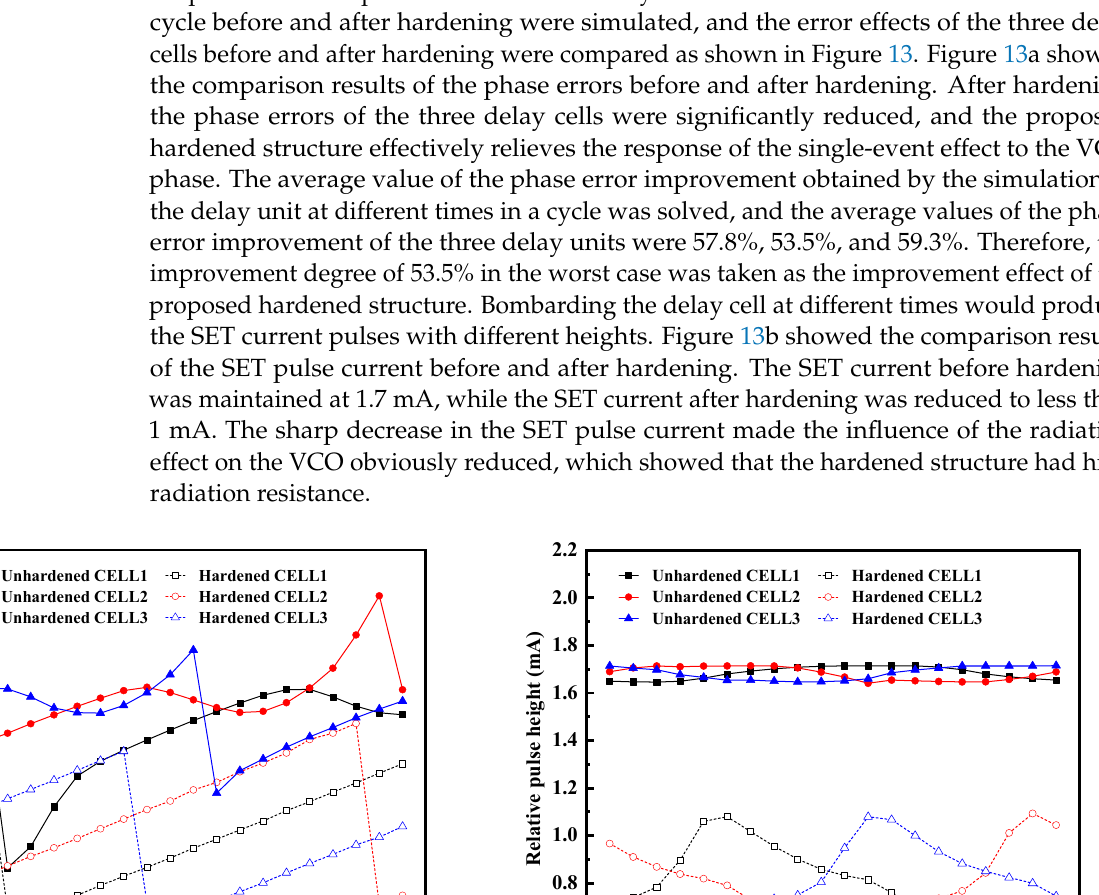
Figure 12. Simulation results of the PLL control voltage disturbance. ( a ) Unhardened VCO. ( b ) Hardened VCO.